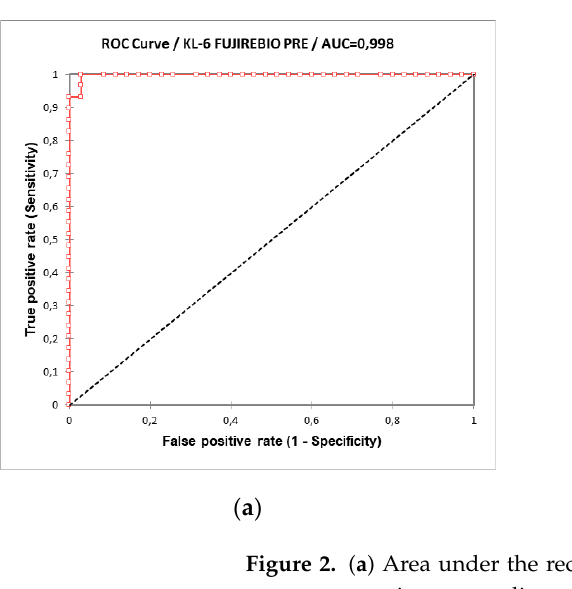
Figure 1. KL-6 concentrations detected by Lumipulse G600II and AIA360 at T0 and T1 stratifying COVID-19 patients according to disease severity. **** p < 0.0001. Receiver operating curve (ROC) analysis showed that KL-6 concentrations, evaluated by Lumipuse G600II (Figure 2), distinguished severe from non-severe COVID-19 patients with an area under the curve (AUC) of 99.8% and the best cut-off value was 448 U/mL with 97.1% specificity and 100% sensitivity.